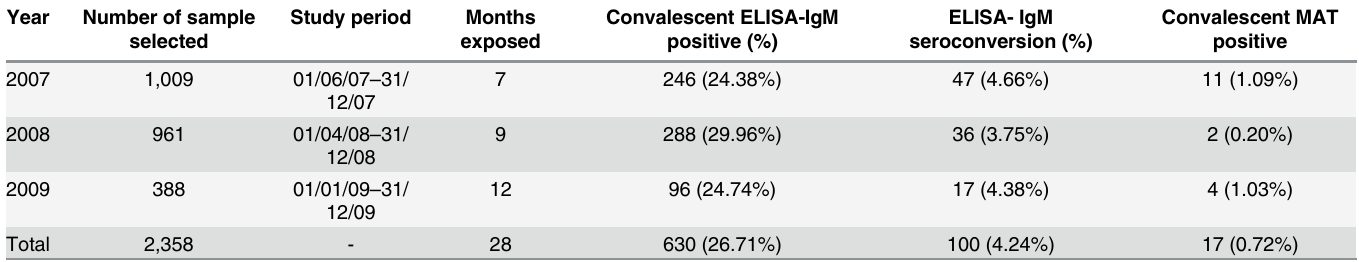
Table 1. Year-specific and study samples enrolment and results of lpetospirosis, febrile episodes, 2007 – 2009 rainy seasons, Kampong Cham province,